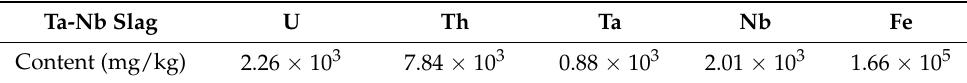
Table 3. ICP–OES element analysis diagram of tantalum niobium slag.